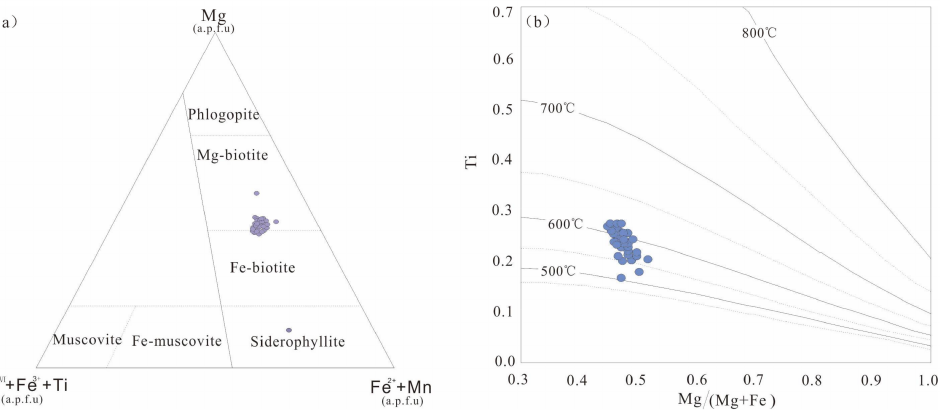
Figure 6. Classification diagram of biotite from the Zhouguan granodiorite ( a ) and Ti vs. Mg/(Mg + Fe) plot of biotite ( b ) (after Foster, 1960 [57]; Henry et al., 2005 [58]).